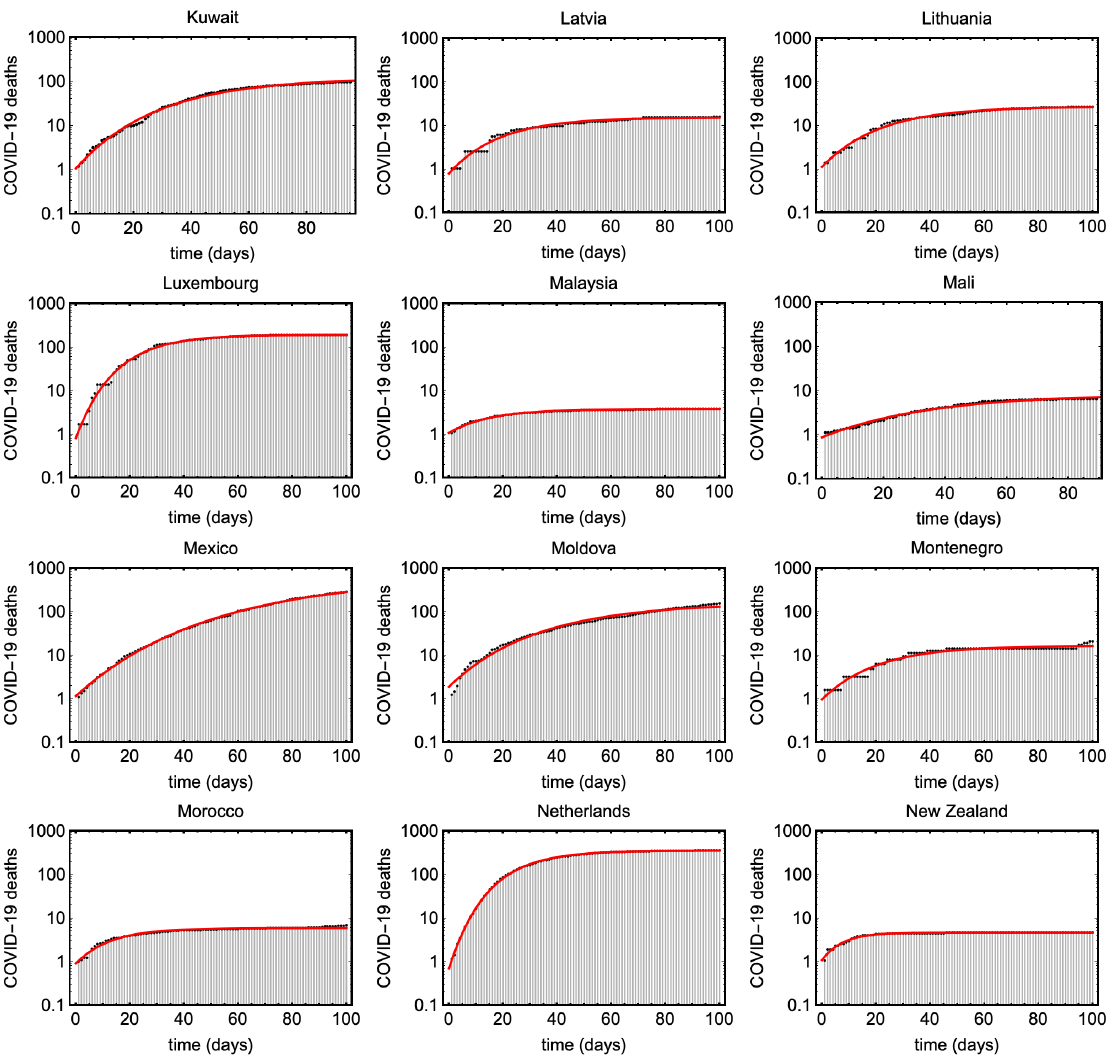
Figure A5. Shows cumulative COVID19 deaths (black) and the estimated Gompertz curves for different countries